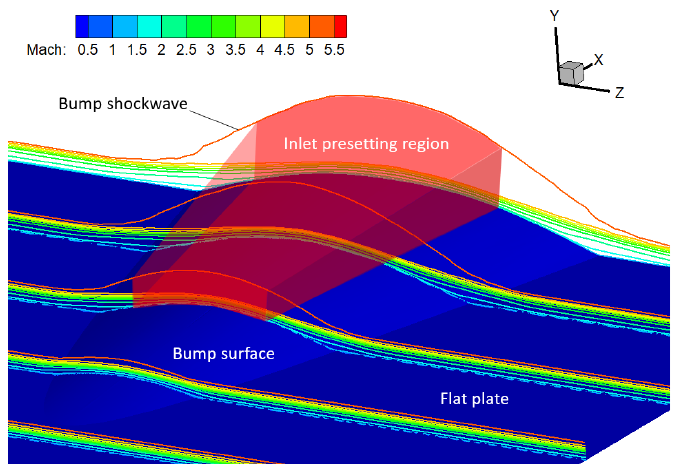
Figure 5. Inlet presetting region over the bump surface.